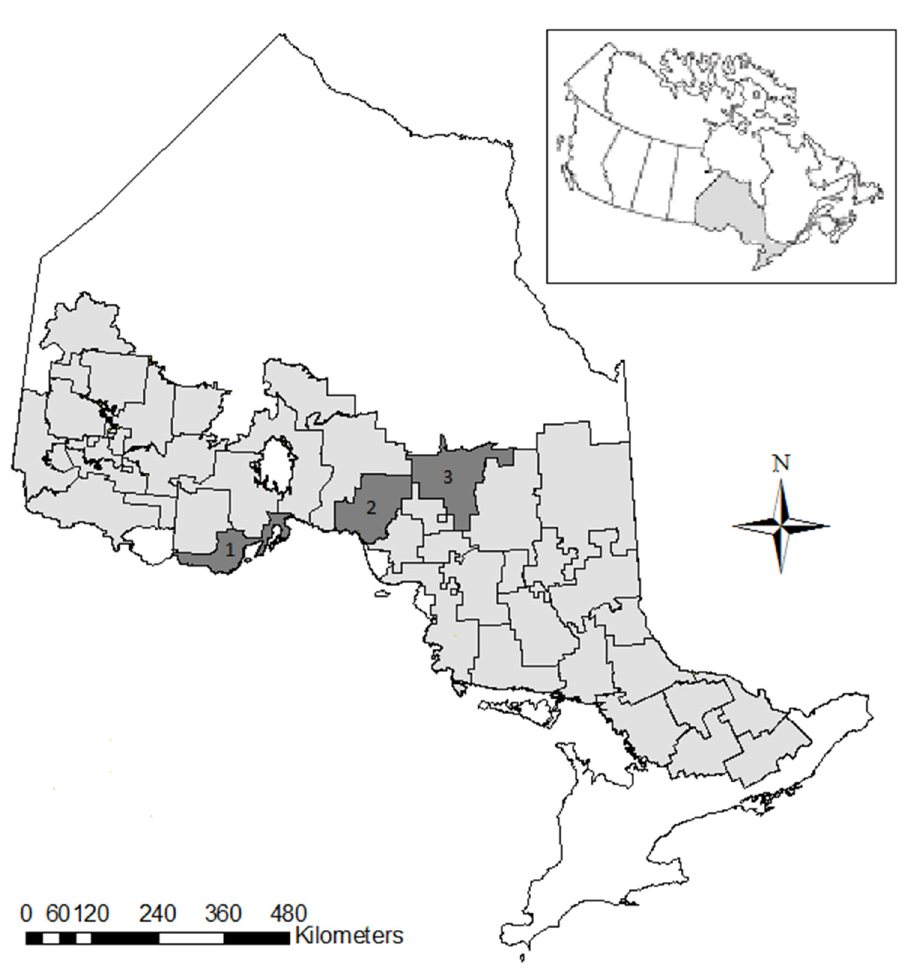
Figure 1. Managed forests (grey) in Ontario, Canada. Dark grey shading indicates the three boreal forest management units used to analyze the effects of harvest age on carbon stocks: 1—Lakehead Forest, 2—Pic River Forest, 3—Hearst Forest.